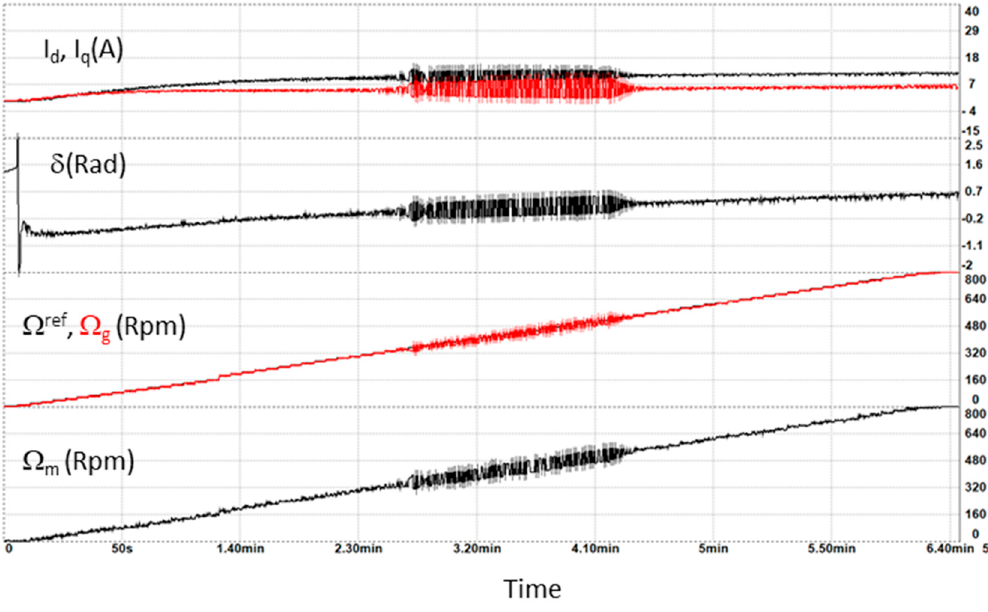
Figure 9. Experimental test with respect to variable stages of the generator speed with a bandwidth of 1 Hz for the generator speed control.